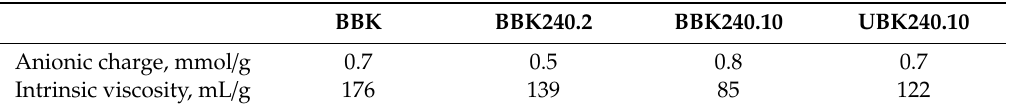
Table 3. Anionic charge and intrinsic viscosity of bleached kraft pulp (BBK) and hot water